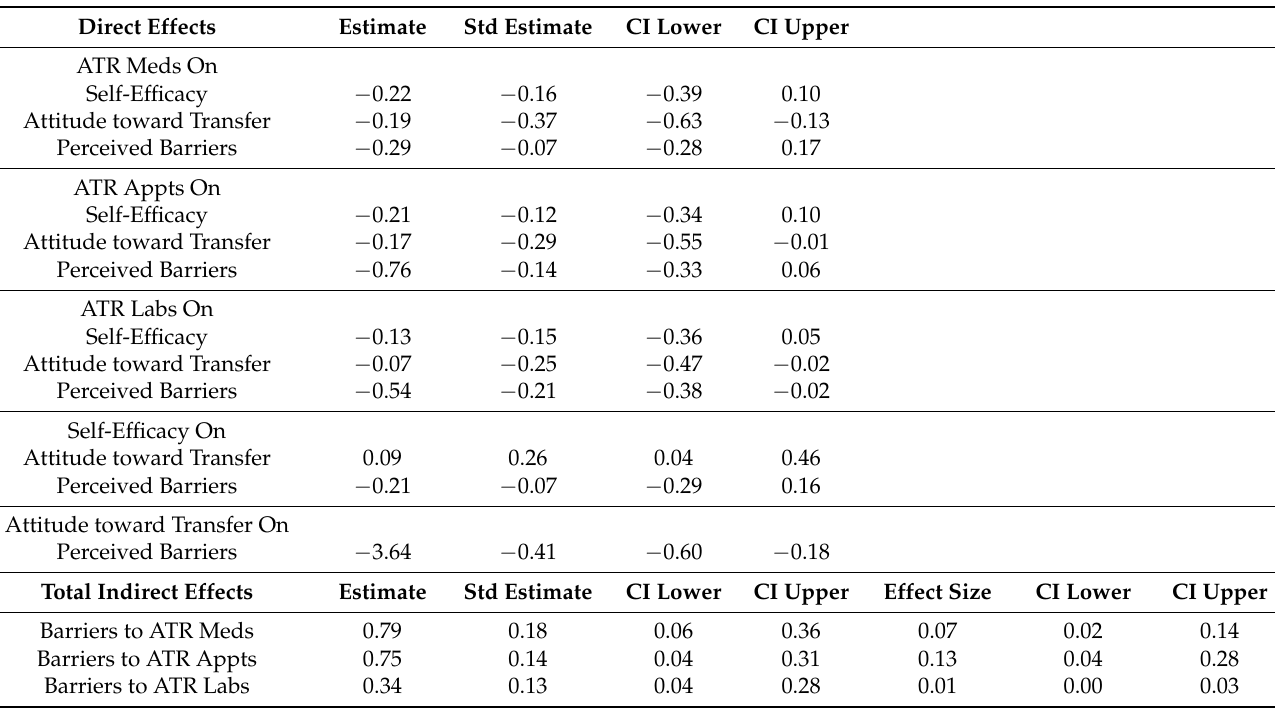
Table 5. Model 2 results: attitudes toward transfer path model estimates of direct and indirect